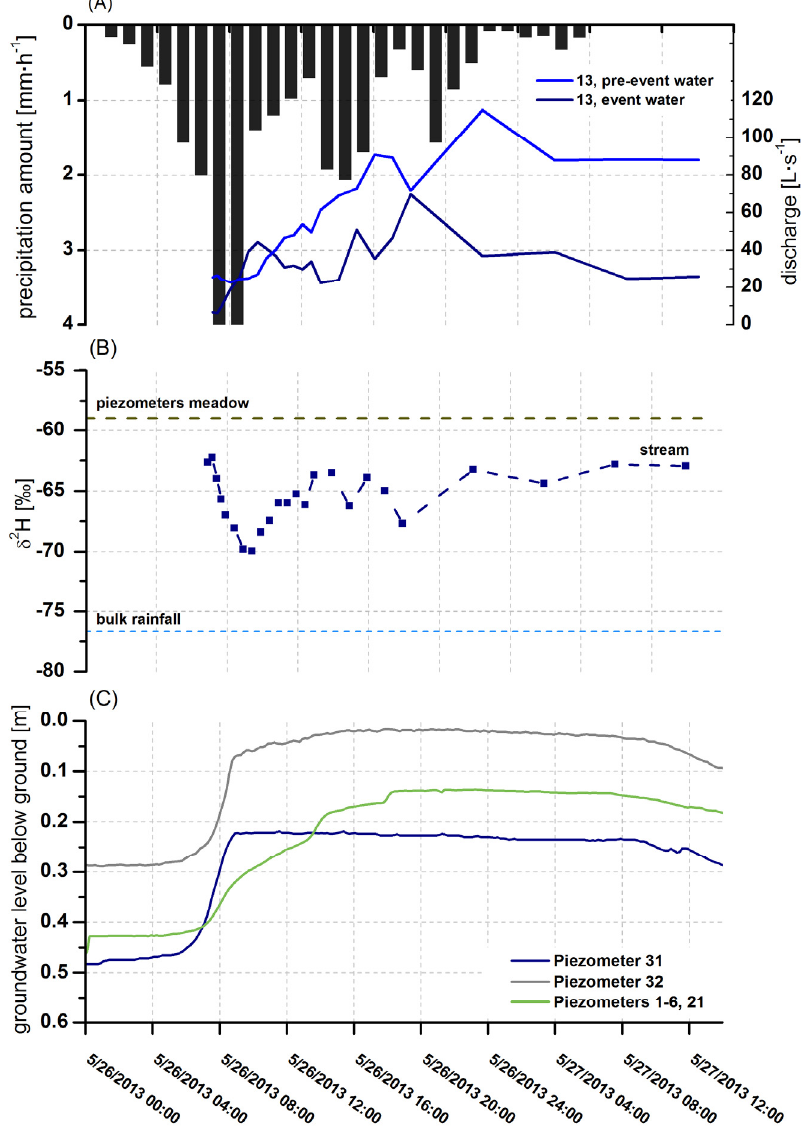
precipitation (mm·h − 1 ), discharge at upper RBC-flume (Figure 2, site 18) and calculated event water contribution at lower RBC-flume (site 13) (L·s − 1 ); ( B ) pre-event δ 2 H in groundwater in the meadow (piezometers 3, 6, 21), δ 2 H in stream and bulk rainfall, and ( C ) groundwater levels below ground (m) for selected piezometers in the meadow (1 – 6, 21) and in the upstream section (31,